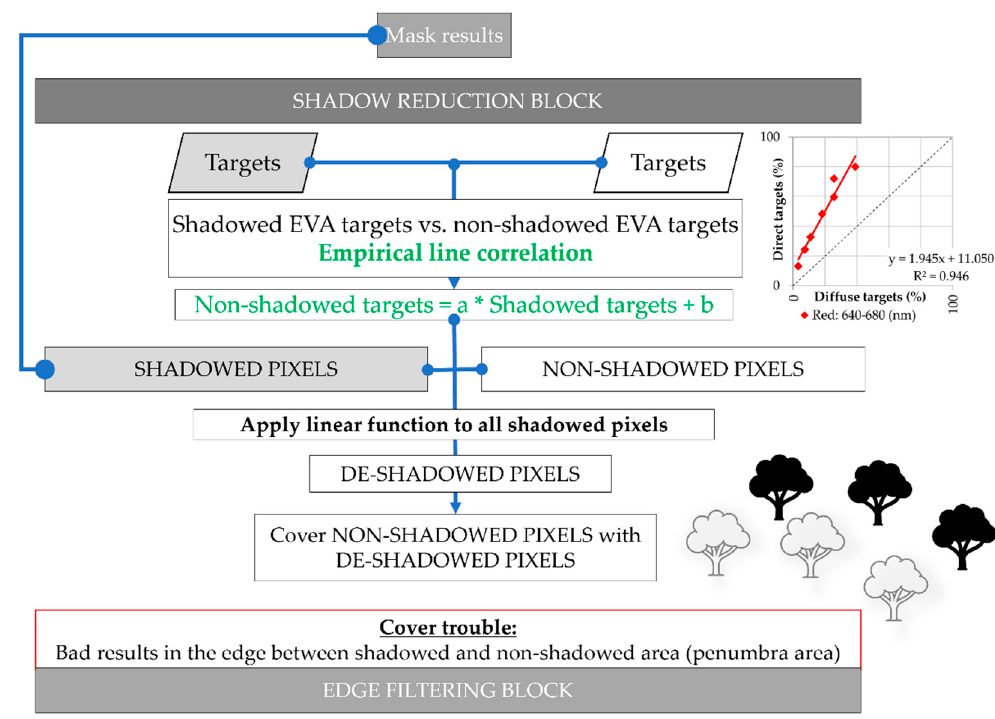
Figure 5. Shadow reduction block methodology: finding the empirical line function from the characterized targets located in shadowed and non-shadowed areas, and further applying it in all the detected shadowed areas.